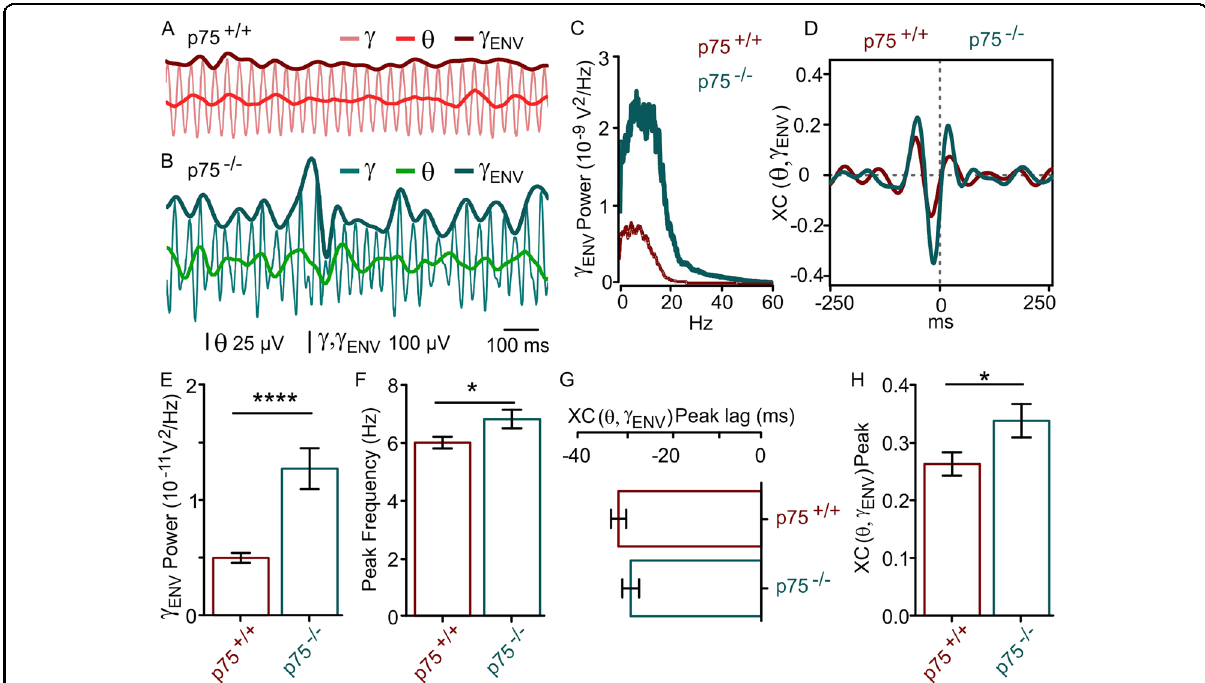
Fig. 5 p75 NTR ablation prevents A β -induced disruption of gamma – theta nesting. A Representative sample trace of CCh-induced LFPs after A β exposure showing a marked reduction of the envelope signal γ ENV (see “ Methods ” ; dark red), γ (light red), and θ (red) signals in p75 + / + mice. B Representative sample trace of CCh-induced LFPs after A β exposure showing no reduction of the envelope signal γ ENV (dark green), γ (light green), and θ (green) signals recorded in p75 − / − mice. C Representative power spectra of the γ ENV signal from p75 + / + (dark red) and p75 − / − (dark green), showing that A β dramatically decreases γ ENV power in p75 + / + mice. D Cross-correlation function of θ with γ ENV (XC( θ , γ ENV )) obtained from the same data as in ( A , B ) showing that A β signi fi cantly affects the magnitude of the θ and γ ENV cross-correlation. E Mean γ ENV power within the θ frequency band shows that A β drastically decreases γ amplitude modulation of p75 + / + γ oscillations, while γ ENV power of p75 − / − mice remains unaltered. F Peak frequency of the spectra as in ( C ) from all slices recorded showing that the γ amplitude modulation is oscillating within the θ range in both p75 + / + and p75 − / − mice. G Quanti fi cation of the XC( θ , γ ENV ) peak lag in both mouse strains showing the phase relationship between θ and γ